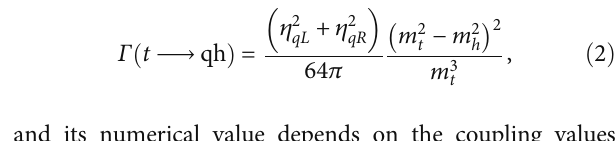
Figure 5: Cross section for the fi nal state including two same-sign lepton at HL-LHC. Comparison of three FCNC scenarios: the matrix element of the FCNC process includes two new physics vertices which are proportional to η 2 η 4 . If c quark does not involve in interactions then cross section depends only on η 4 q